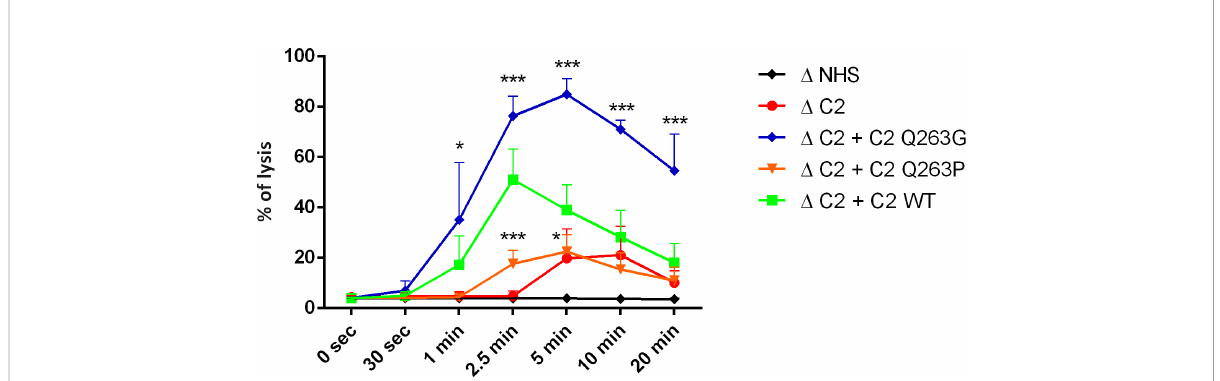
FIGURE 2 Activity of CP/LP C5 convertase formed by C2 variants. Antibody-sensitized human erythrocytes were incubated with D C2 serum supplemented with C2 variants and eculizumab for indicated time period to build C5 CP/LP convertases on the cell surface. Afterward, cells were washed and overlaid with guinea pig serum diluted in EDTA-buffer to form membrane attack complexes on the platform of preexisting convertases. The readout of released hemoglobin was calculated as percentage of full lysis achieved by addition of distilled water. Symbols *, and *** denote statistical signi fi cance at p levels <0.05, and <0.001, respectively, according to Holm-Sidak ’ s multiple comparison test.